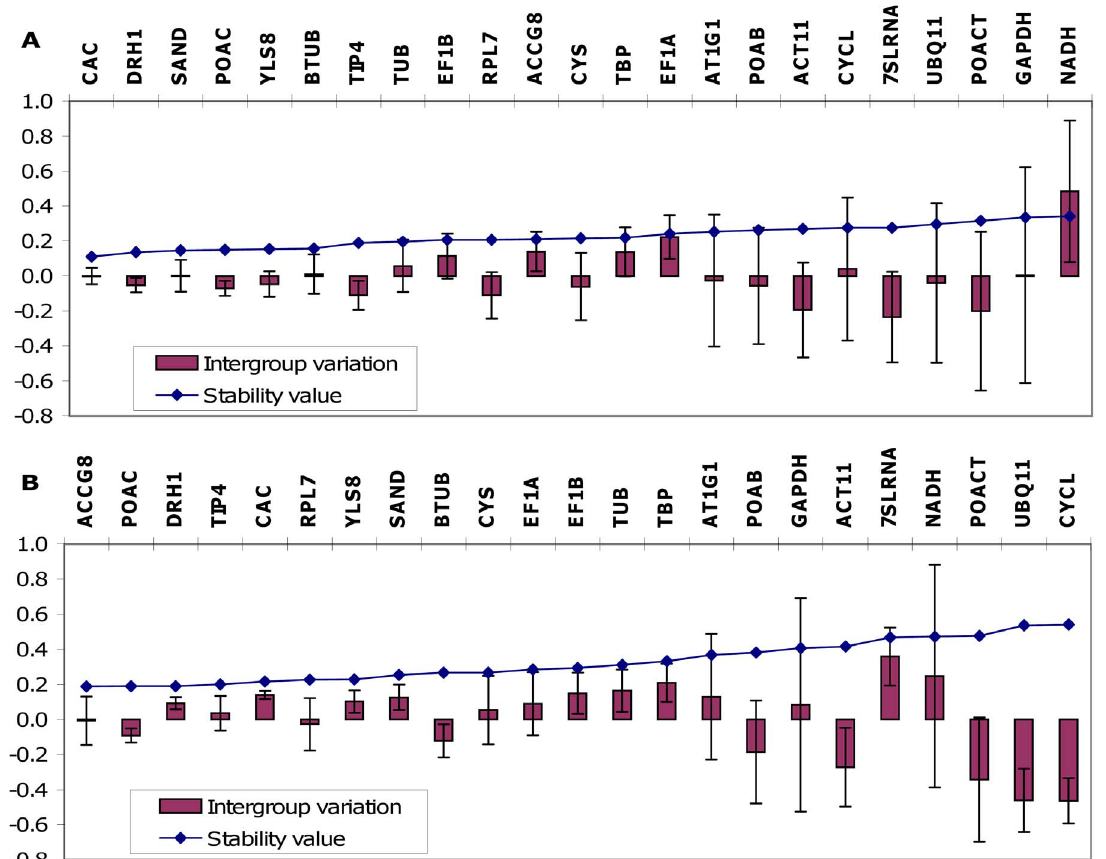
Figure 5. Stability values and estimated inter- and intra-group variances for different grouping calculated by NormFinder. (A) infected vs. non-infected plants and (B) susceptible vs. resistant plants. The intra-group variation is represented as error bars.